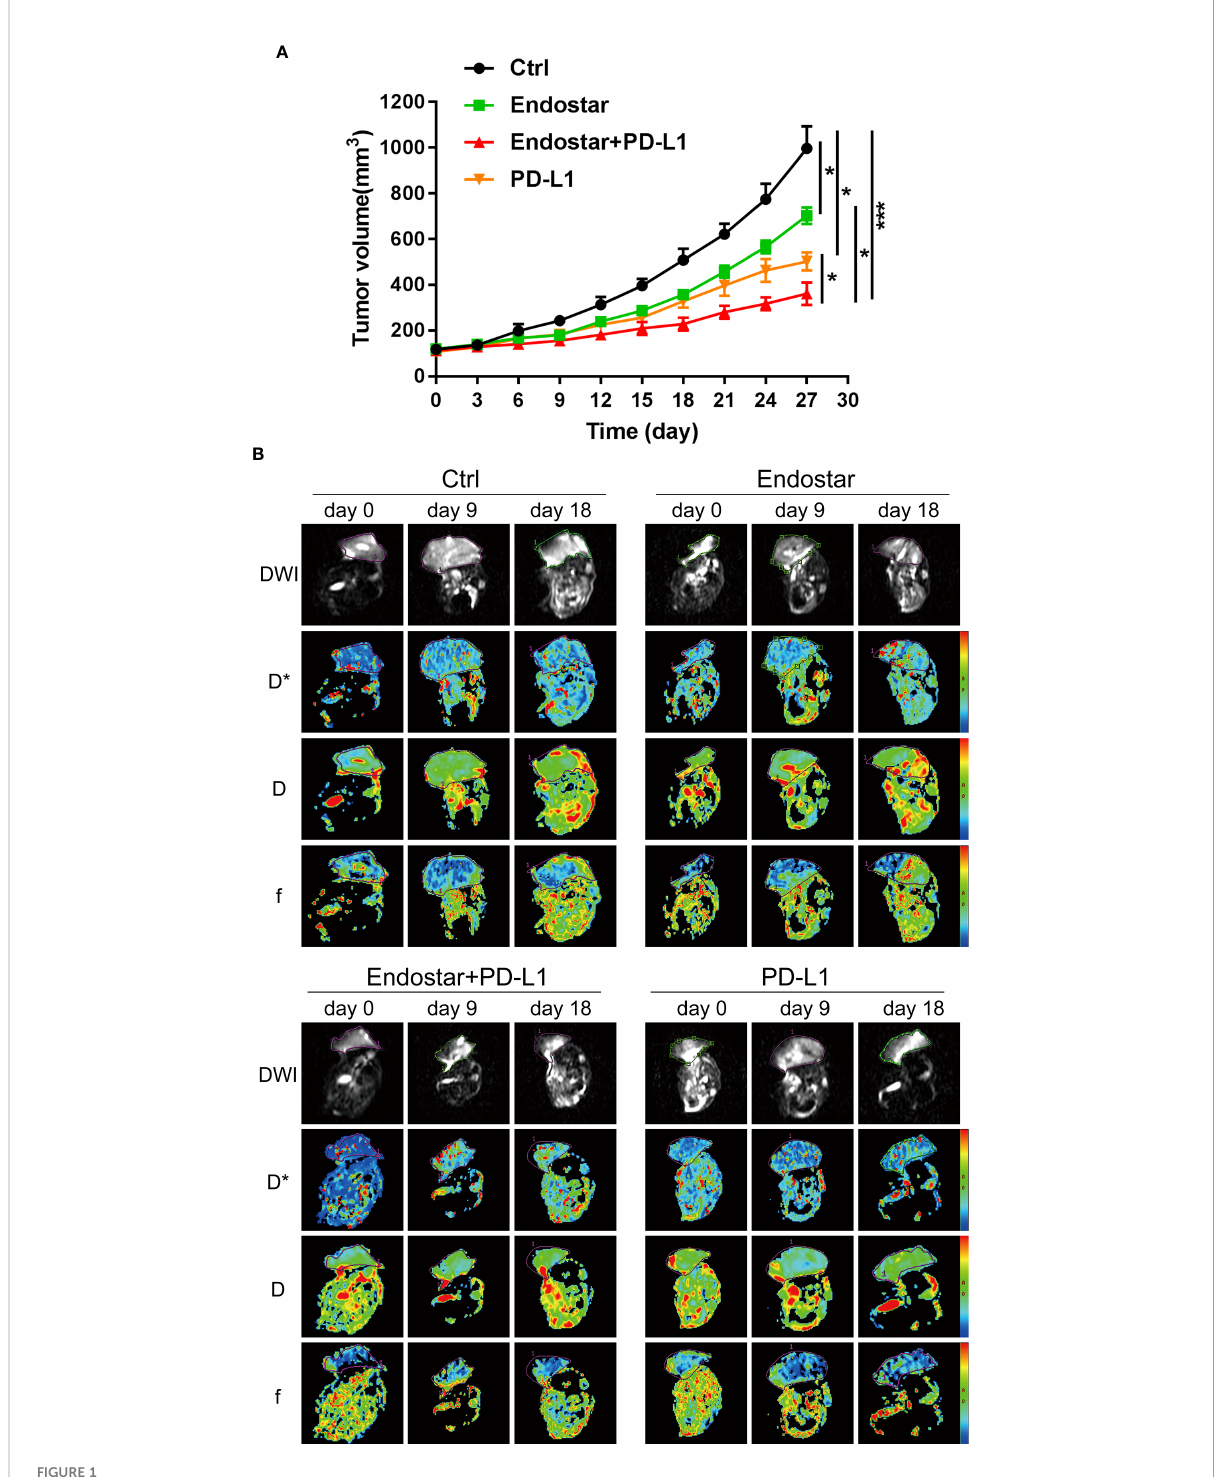
FIGURE 1 Evaluation of the antitumor effect of Endostar combined with programmed death ligand-1 (PD-L1) inhibitor. (A) The effect of Endostar combined with PD-L1 inhibitor on the xenograft volume of CT26 mice (*P< 0.05; ***P< 0.001). (B) Intravoxel incoherent motion diffusion- weighted magnetic resonance imaging (IVIM-DWI MRI) is used to evaluate the tumor microcirculation of colorectal cancer (CRC) intervention mice in Endostar, Endostar+PD-L1, and PD-L1 groups. IVIM-DWI MRI was performed before the intervention and on the ninth and 18th days after the